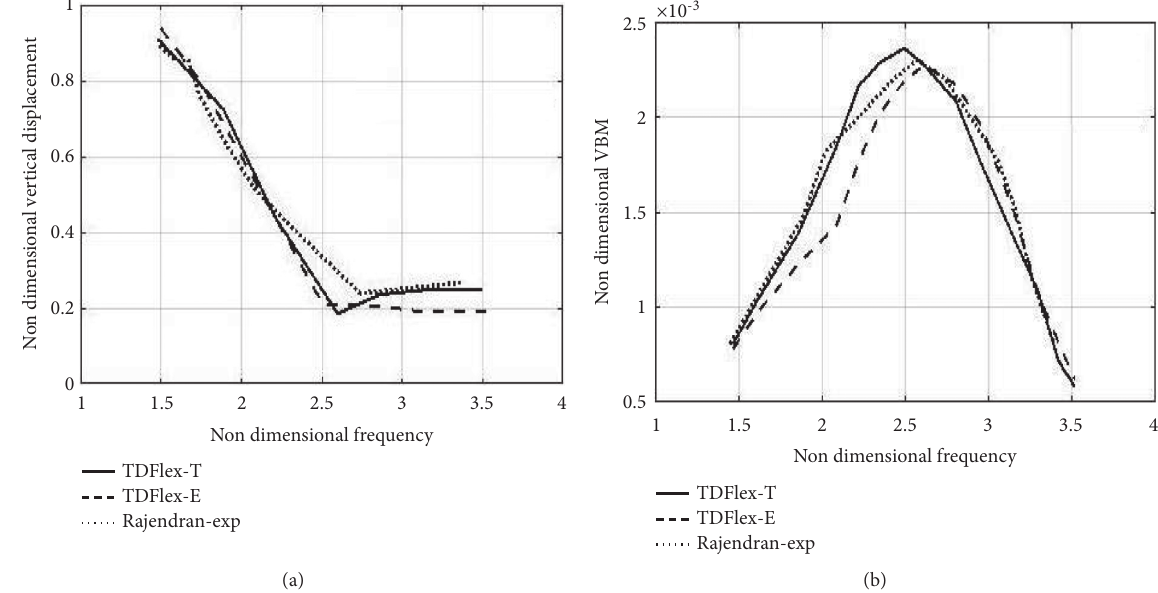
Figure 7: Symmetric responses, LC (at F